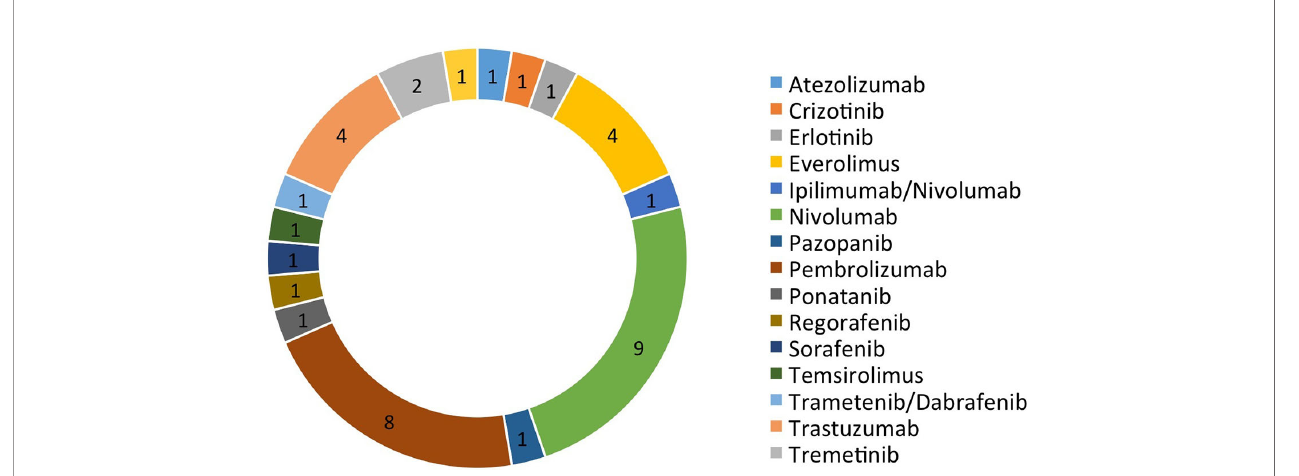
FIGURE 3 | Targeted treatment received and